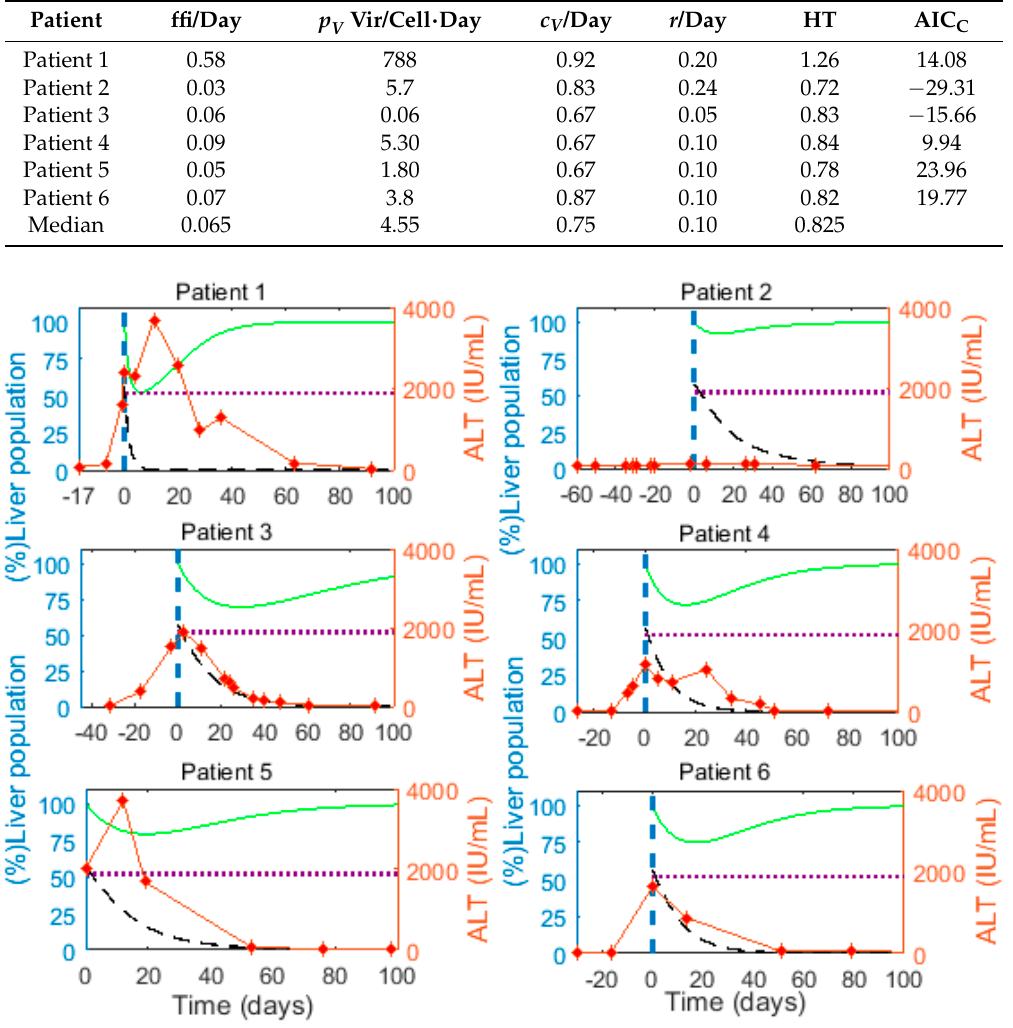
Figure 3. (Left) Y-axis: Predicted (%) infected cell population ( I , black dashed line) and (%) total liver cell population (100 ( I + T + θ H ) / H , green solid line) calculated from M1 using the best-fit parameters in Table 3. The dotted horizontal line represents the critical threshold for the liver cell population during the process of infection clearance, which is 52% of H . (Right) Y-axis: Alanine aminotransferase (ALT, IU/mL) measured in patients (red diamond markers and red line). The vertical dashed line represents time 0, when we start analyzing/fitting the viral load.